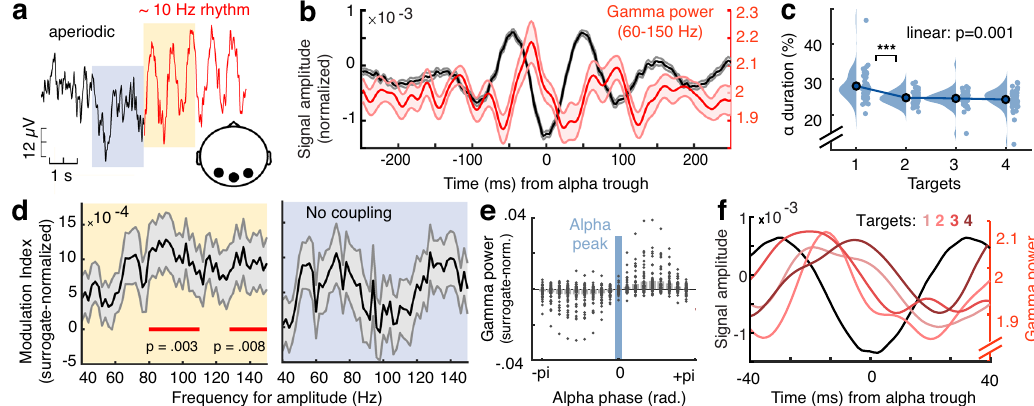
Fig. 4 Alpha phase modulates gamma power during sensation. a Exemplary time series around the onset of a detected alpha episode (example from four- target condition). Segments were pooled across occipital channels (black dots in inset topography) and target load conditions. b Normalized gamma power (red) during alpha episodes (yellow shading in a ) is modulated by the alpha phase (see “ Methods ” ). The un fi ltered ERP aligned to the alpha trough is shown in black. Data are presented as mean ± SEM. c The relative duration of alpha ( α ) episodes decreased with increased feature relevance. Data are within-subject centered (see “ Methods ” ). Panel c indicates p values from two-tailed paired t -tests (*** p = 3.6e − 5, linear: b = − 1.17, 95% CI = [ − 1.81, − 0.53], t (46) = − 3.67), pairwise comparisons were Benjamini – Hochberg-adjusted for multiple comparisons. d Modulation index (MI) indicated signi fi cant coupling between the phase of alpha and gamma power during rhythmic events (left), but not during periods immediately prior to rhythm onset (right). MI was normalized using surrogate data to reduce erroneous coupling (see “ Methods ” ). Panel d indicates p values from paired t- tests against zero, corrected for multiple comparisons via cluster-based permutations. Data are presented as mean ± SEM. e Gamma power (averaged from 60 to 150 Hz; dots indicate n = 47 participants) was maximal following alpha peaks. Power was normalized across all phase bins (see “ Methods ” ). f Gamma power systematically peaks between the peak and trough of alpha rhythms across target levels. For this analysis, alpha episodes were collapsed across all participants. n = 47 participants in all panels. Source data are provided as a Source Data fi